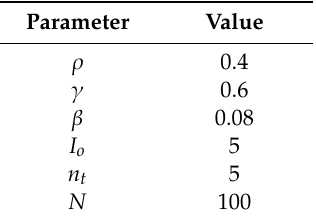
Table 3. Parameter settings of